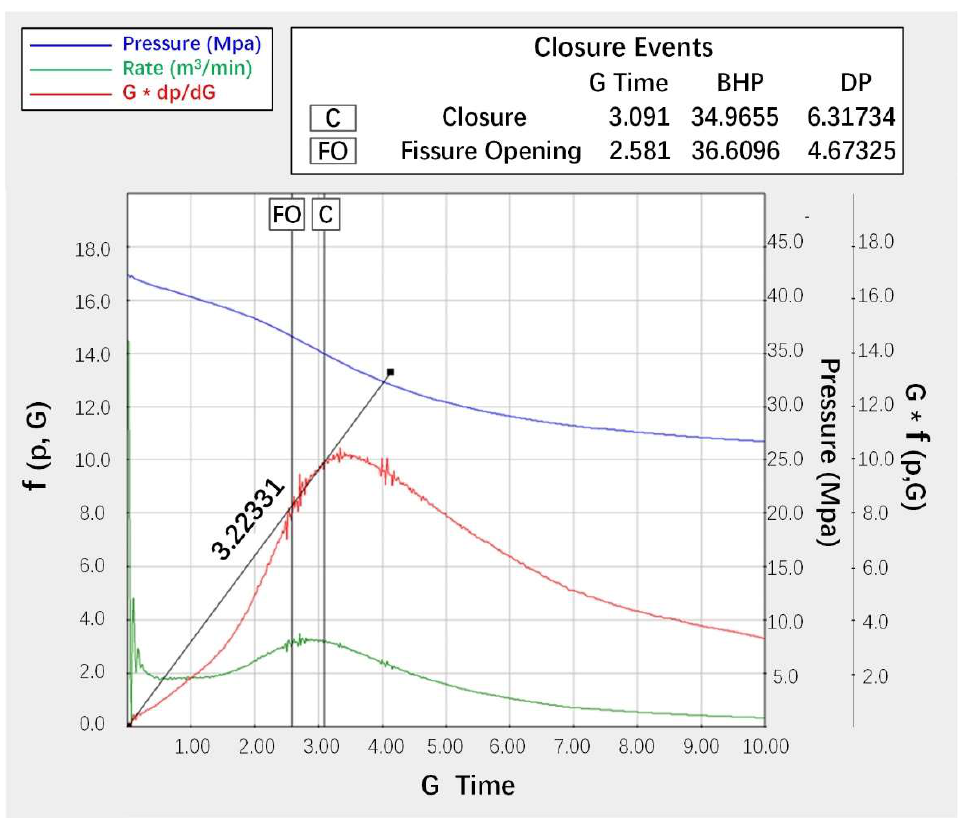
Figure 10. Closure pressure determination by the Tangent method using filtered filed DFIT data. After the fracture closure time, the reservoir flow starts to dominate the process, and the pore pressure is estimated by pressure transient analysis. The adjacent reservoir fluid first flows in the induced fracture by a 1D flowing pattern, resulting in the linear flow regime, as implied by the slope of − 0.5 on the pressure derivative plot. Later, the fracture starts to deplete the fluid further into the reservoir by a 2D flowing pattern, contributing to the radial flow regime, measured by a slope of − 1 on the pressure derivative plot. Both flow regimes are observed in the Well-A DFIT, as shown by the red (linear) and green lines (radial) in Figure 11. Based on the plot, the linear flow regime starts from 34 min, and the radial flow regime starts from 58 min. To estimate the pore pressure, the pressure data in the linear flow regime are regressed linearly in a log–log plot of pressure vs. inverse of square root of time, as shown in Figure 12, and the pressure data in the radial flow regime are regressed linearly in Horner plot, as shown in the inserted image in Figure 12. The pore pressure is determined by the intercept of the y-axis and regressed straight line for both methods. In general, the pore pressure by the radial flow regime shows an upper bound estimation, and the linear flow gives a lower bound estimation. As demonstrated in Figure 12, the pore pressure of Well-A by the radial flow regime is estimated to be 24.58 MPa, contributing to the pore pressure gradient of 10.07 KPa/m; the pore pressure of Well-A by the linear flow regime is estimated to be 20.82 MPa, resulting in the pore pressure gradient of 8.54 KPa/m. As a result, the Well-A DFIT analysis estimates that the pore pressure ranges from 20.82 to 24.58 MPa, contributing to the pore pressure gradient from 8.54 to 10.07 KPa/m for the